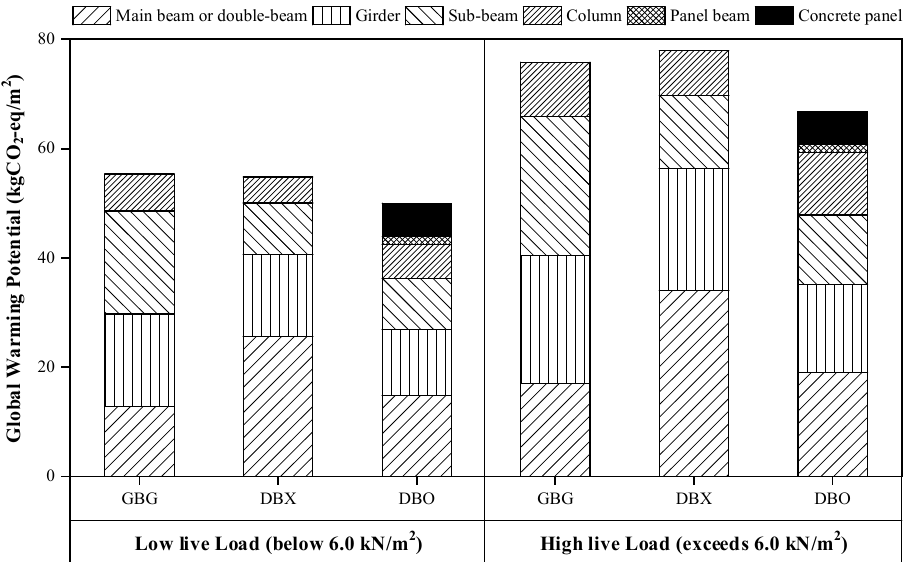
Figure 8. Comparison of global warming potentials (GWPs) between the general beam-girder system (GBG) and the double-beam floor systems with concrete panel (DBO) and without concrete panel (DBX).